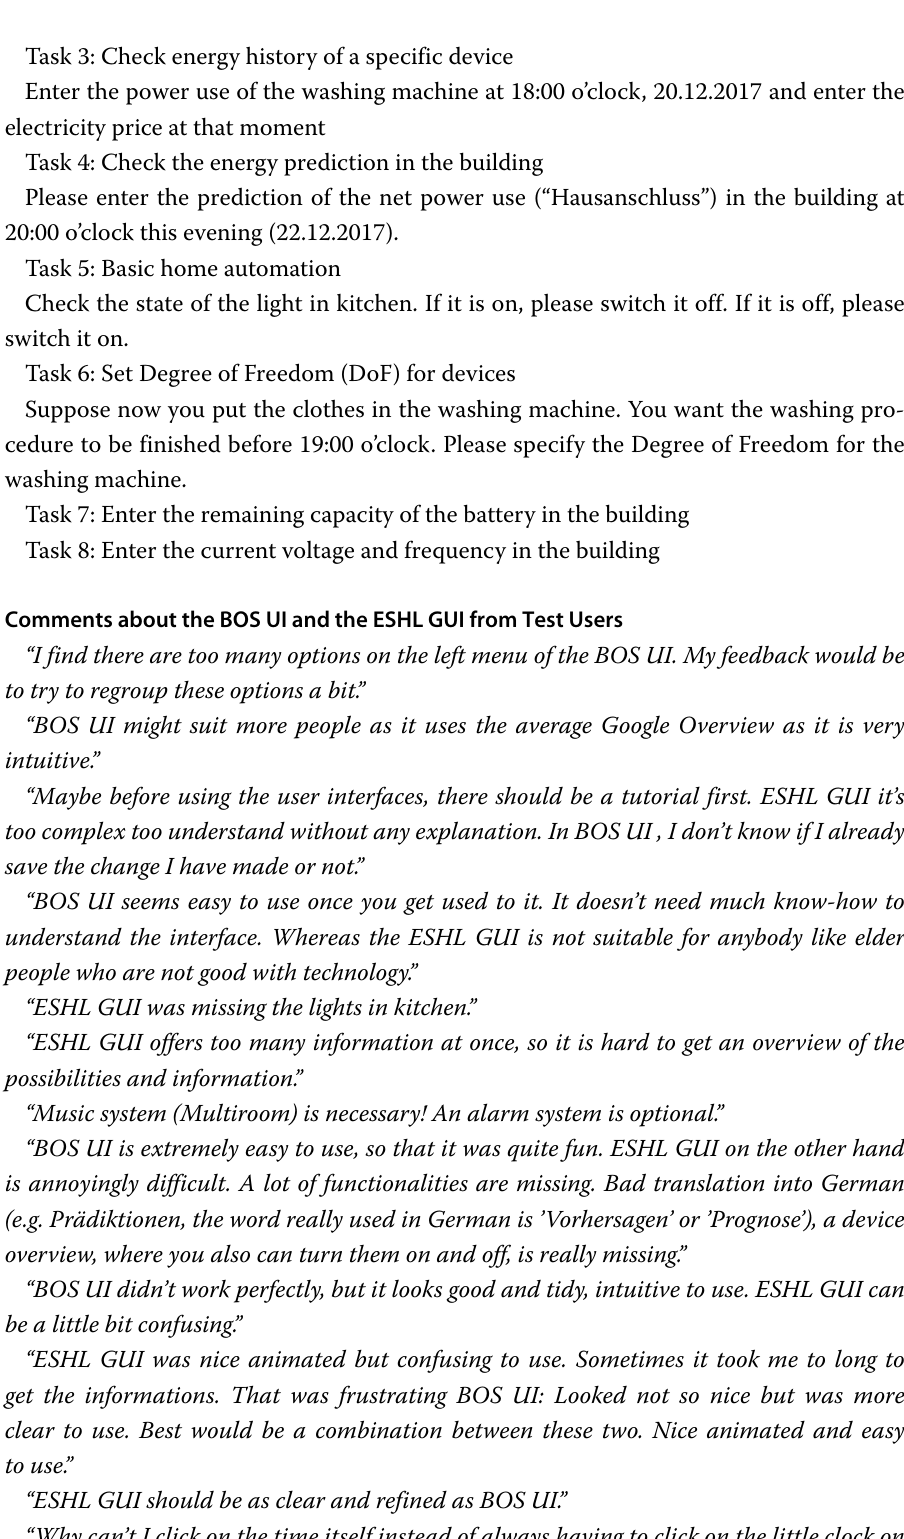
Task 3: Check energy history of a specific